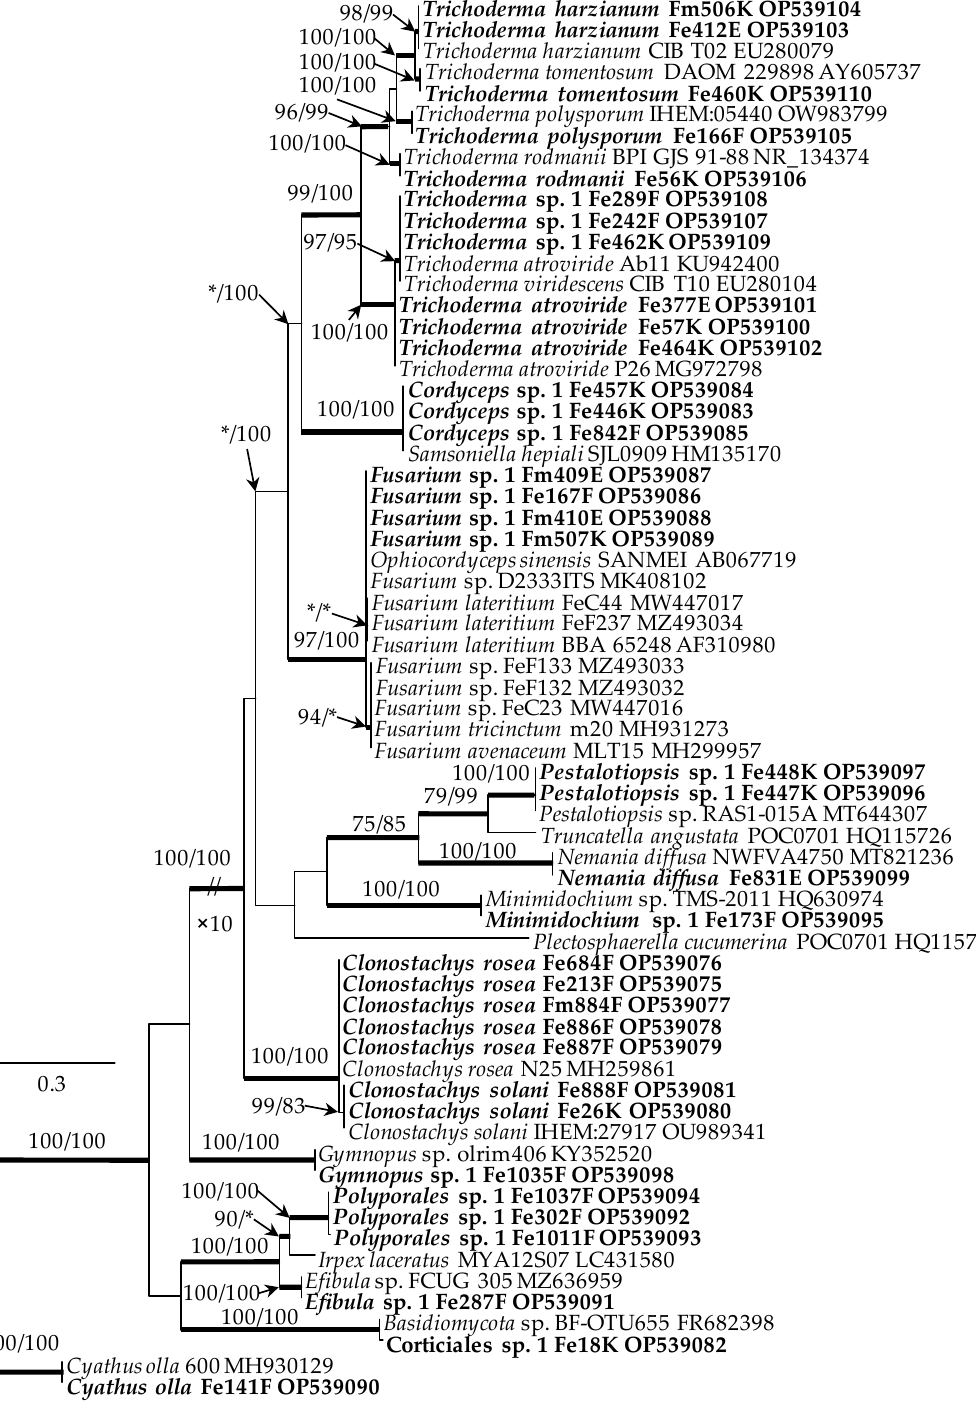
Figure 3. Phylogram obtained from Maximum Likelihood (ML) analyses of the ITS data for the isolated fungal taxa. Sequences obtained during this study are presented in bold type. The Bootstrap values ≥ 75% for ML and Maximum Parsimony (MP) analyses are presented at nodes as follows: ML/MP. Bold branches indicate posterior probabilities values ≥ 0.95 obtained from Bayesian In- ference (BI) analyses. * Bootstrap values < 75%. The scale bar corresponds to expected number of substitutions per nucleotide site. Cyathus olla was used as the outgroup